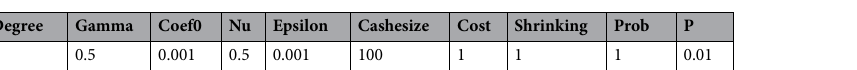
Degree Gamma Coef0 Nu Epsilon 0.01 Table 7. SVMR model parameters. Note: Degree: set degree in kernel function; Gamma: set gamma in kernel function; Coef0: set coef0 in kernel function; Nu: set the parameter nu of nu-SVC, one-class SVM, and nu-SVR; Epsilon: set tolerance of termination criterion; Cashesize: set cache memory size in MB; Cost: set the parameter C of C-SVC, epsilon-SVR, and nu-SVR; Shrinking: whether to use the shrinking heuristics, 0 or 1; Prob: whether to train a SVR model for probability estimates, 0 or 1; P:set the epsilon in loss function of epsilon-SVR.